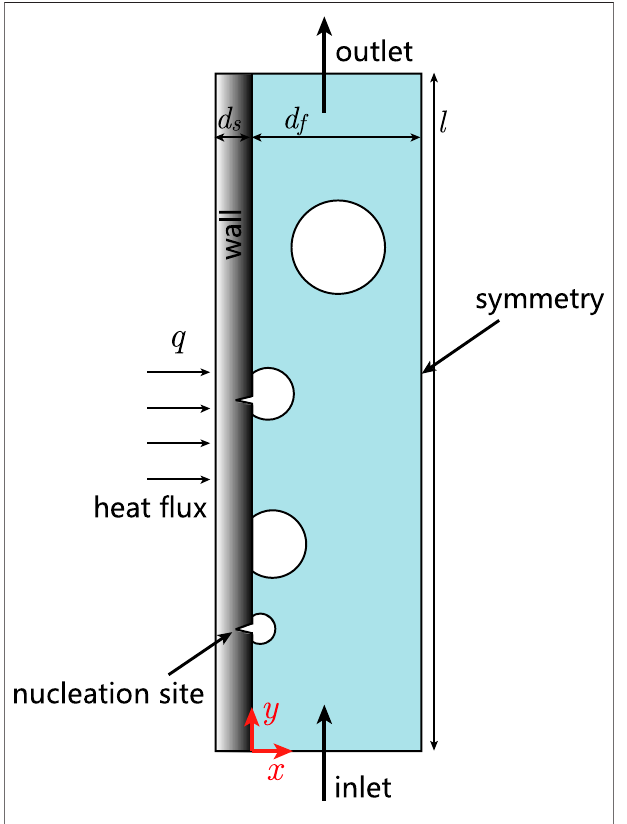
FIGURE 1 | The subcooled fl ow boiling problem and applied boundary conditions.